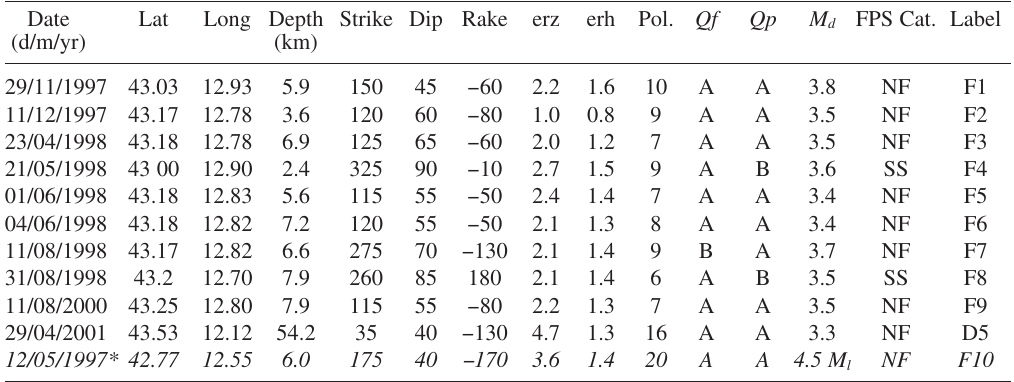
Table IV. First Motion Polarities. Hypocentral parameters; magnitudes (code magnitude M d and Richter mag- nitude M l ); location errors; strike, dip, and rake of the first nodal plane dipping to the east clockwise from north; number of polarities; quality factors; and fault-plane solution categories for the 11 selected focal